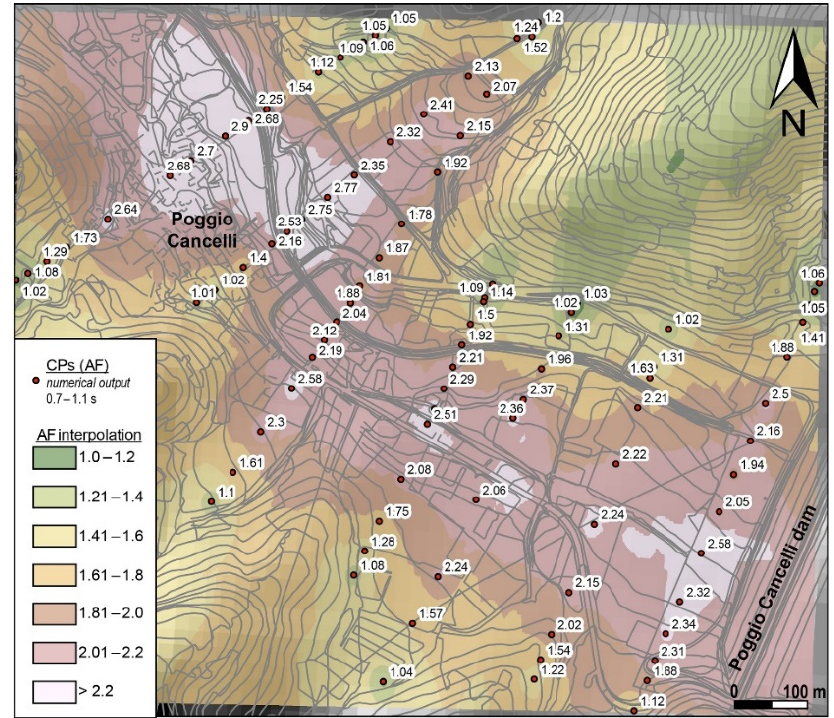
Figure 13. Map showing the amplification factors (AF) value distribution for the period 0.7–1.1 s in the Poggio Cancelli area.